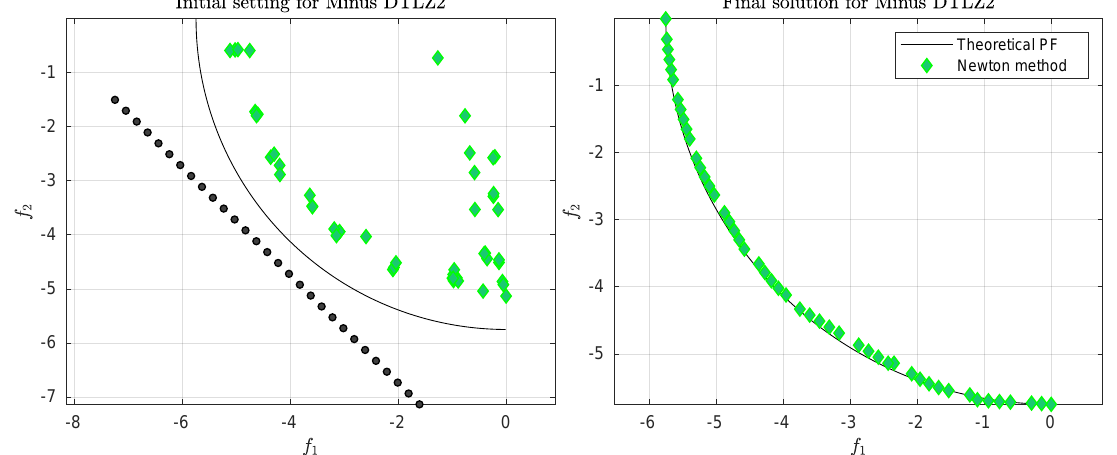
Figure 19. Initial candidate set ( left ) and numerical result of the ∆ 2 -Newton method on minus DTLZ2 ( right